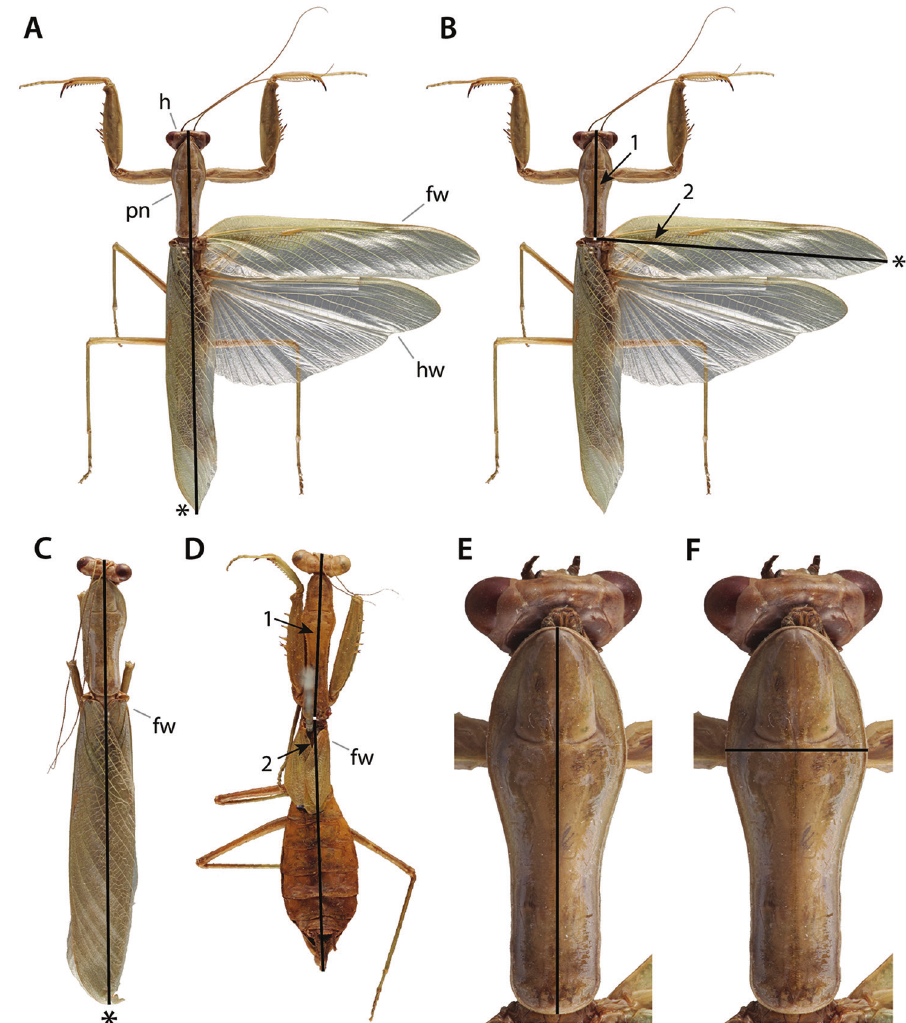
Figure 25. Body and pronotal measurement standards. Solid black lines indicate approximate location to take length and width measurements. Sphodromantis sp. prepared specimen: A body length measurement method 1; B body length measurement method 2, with measurements designated 1 and 2 indicating the first and second measurements needed for the body length measurement, which, when summed together result in total body length C Sphodromantis sp. unprepared specimen D Stagmomantis nahua Saussure, 1869 unprepared brachypterous specimen with the sum of measurements designated 1 and 2 equaling total body length. Sphodromantis sp. pronotal measurements E length F width. Asterisks (*) represent potential areas where specimen damage may result in an inability to take an accurate measurement (e.g., wing tip damage). Abbreviations: fw = forewing; h = head; hw = hindwing; pn = pronotum. measurement should be parallel to the supracoxal sulcus. For pronotal length, measure along the midline of the pronotum from the anterior margin to the posterior margin; the measurement should be perpendicular to the supracoxal sulcus (Fig. 25e). For